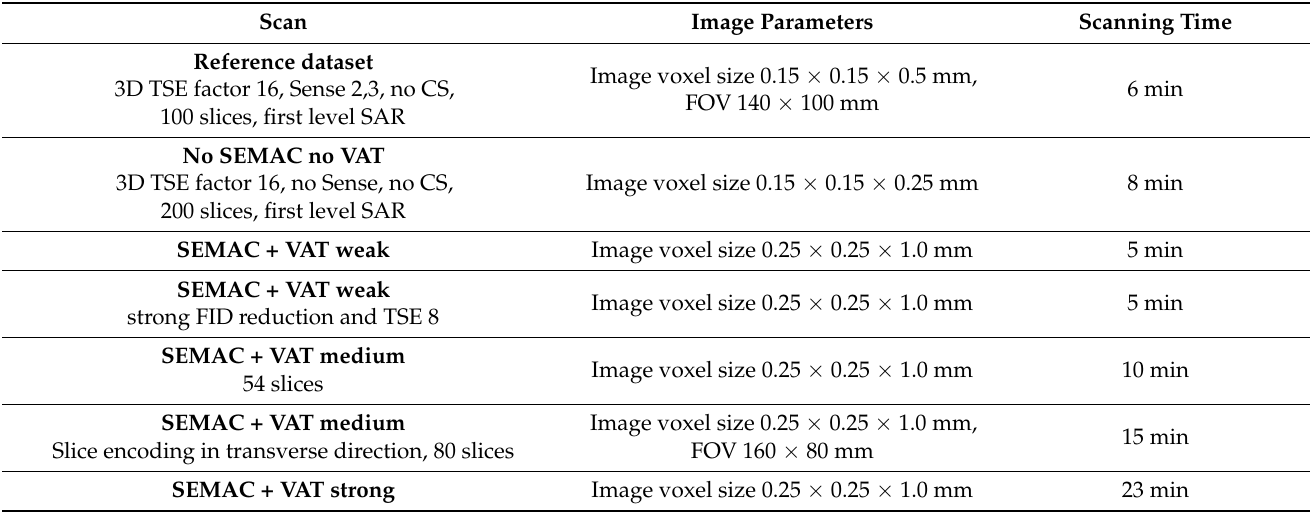
Table 2. MRI-sequences tested for this study. Turbo spin echo (TSE) in 3D and parallel (Sense) in first level SAR acquisition sometimes using compressed sensing (CS); SEMAC—slice encoding for metal artifact correction; VAT—view angle